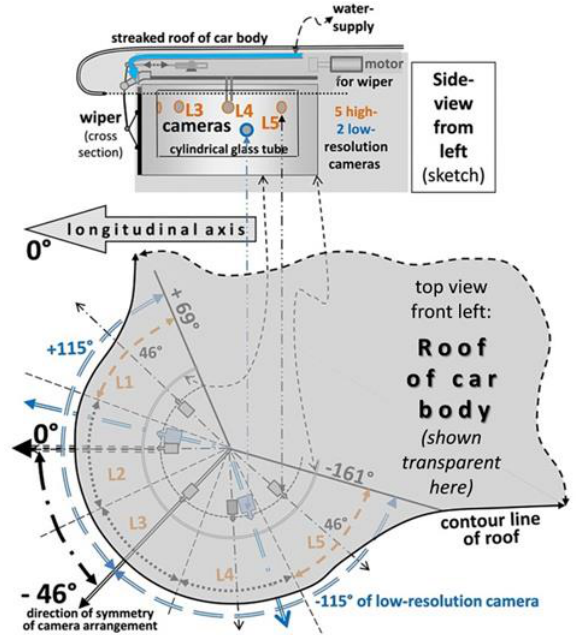
Figure 21. Body-fix left-side eye: The specific FoV as given in Figure 13 are shown in the lower part (by making the roof transparent here). The two low-resolution cameras (in blue) cover the same FoV as all higher-resolution cameras together (230° from –161° to + 69°); their images meet at the gaze direction of –46°. The top part sketches a view from the left-hand side; the cameras are inside a cylindrical (semi-transparent) glass tube that is kept clean by a wiper, whose rest position is at the right corner.